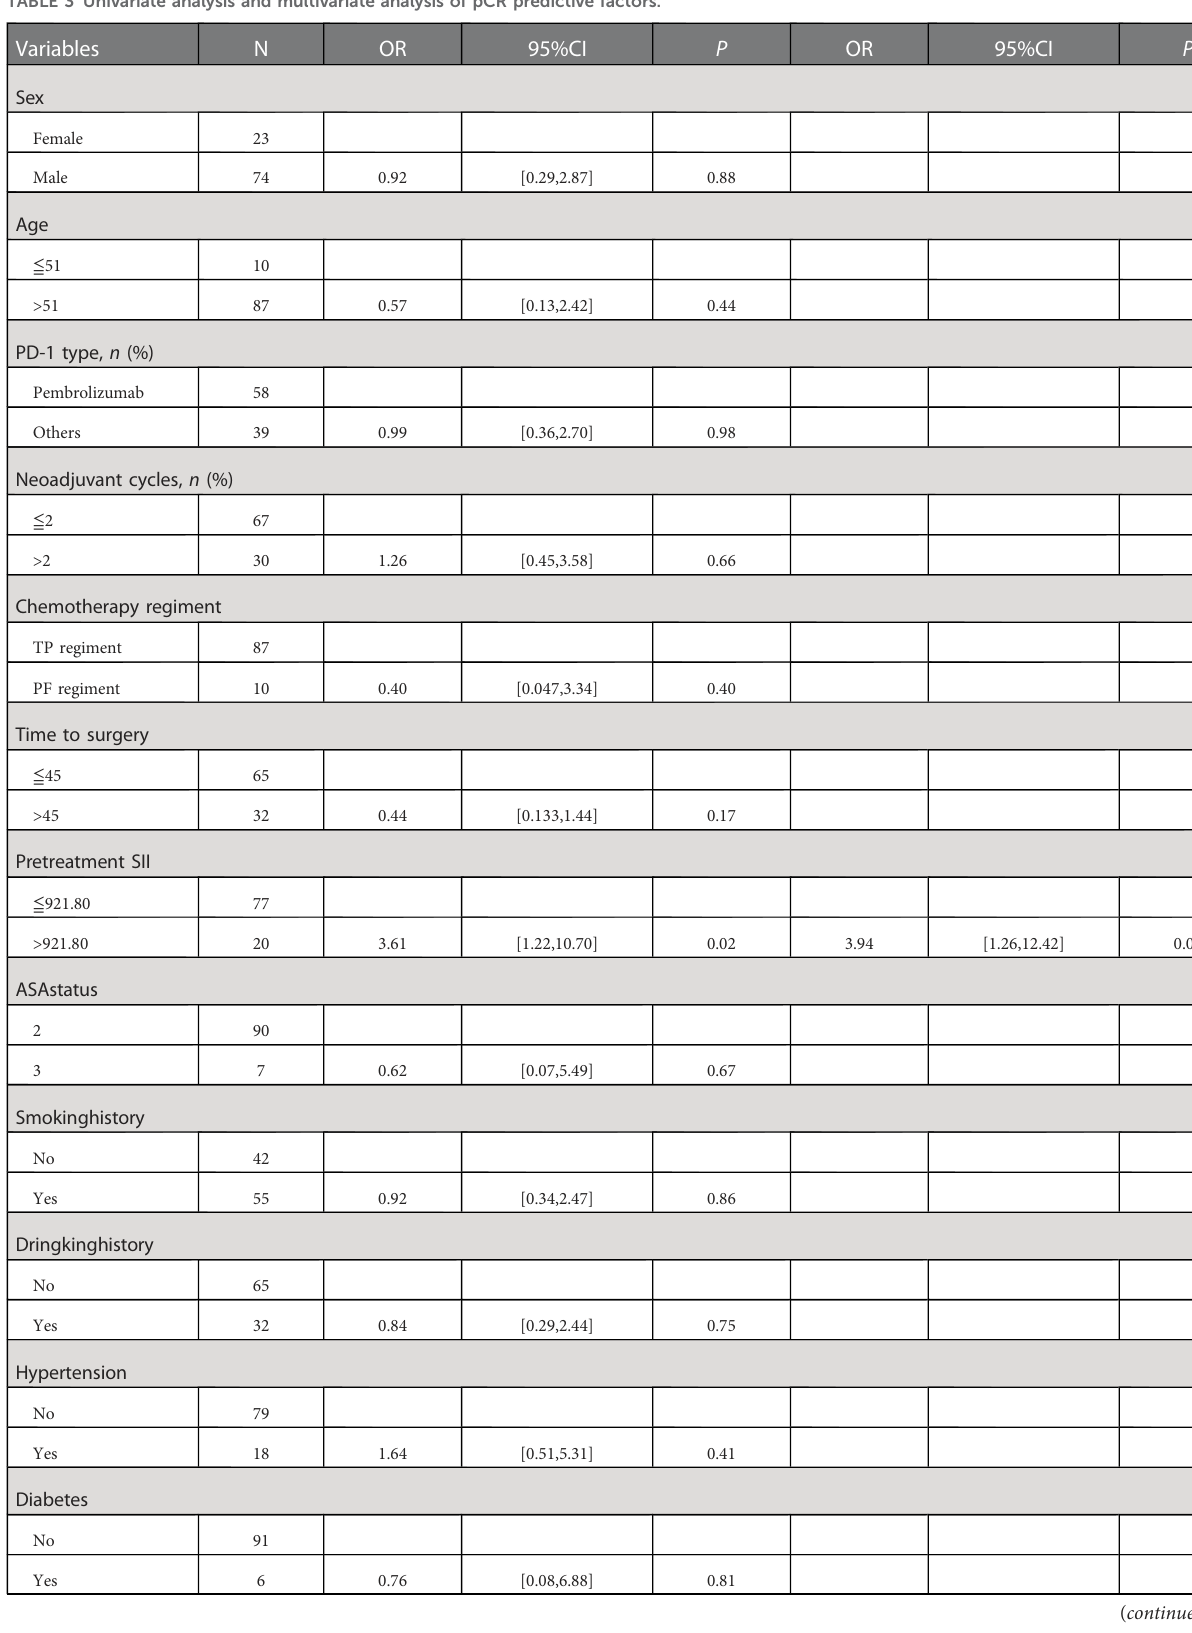
TABLE 3 Univariate analysis and multivariate analysis of pCR predictive